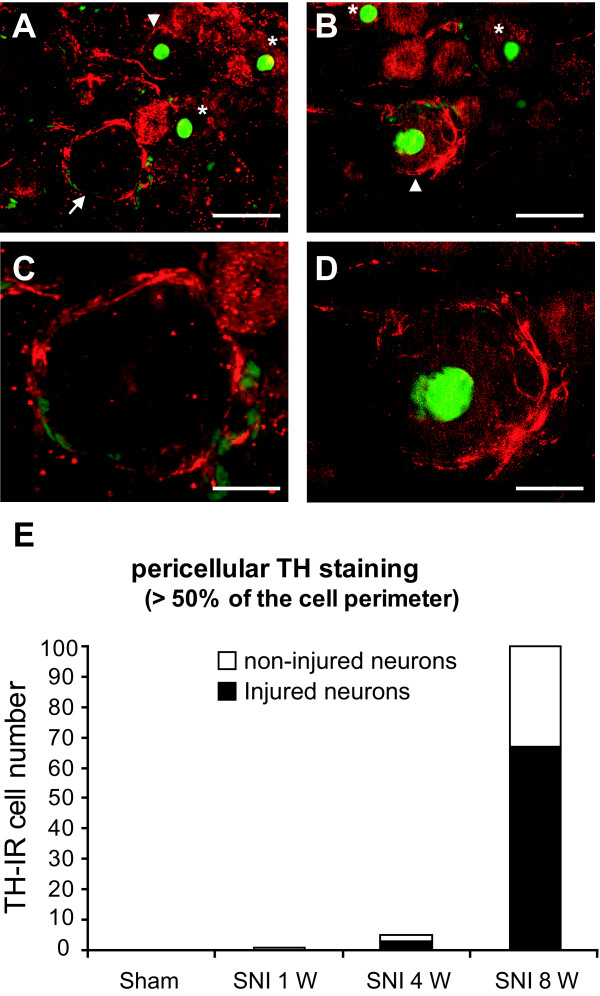
TH-IR and pericellular baskets in injured and non-injured DRG neurons. A to D Representative photomicrograph of double fluorescent immunohistochemistry for ATF3 (green) and TH (red) in L4 DRG 8 weeks after SNI. A and B, TH-IR fibers surround both non-injured (arrow), and injured cells (arrowhead, ATF3 positive). Not all injured neurons (asterisks) are encircled by TH-IR fibers, scale bar 25 μm. C and D, TH-IR pericellular basket structures around non-injured (C) and injured (D) DRG neurons, scale bar 10 μm. E, Quantification of TH-IR pericellular basket in injured and non-injured DRG neurons in control and SNI groups (1, 4 and 8 weeks after surgery).